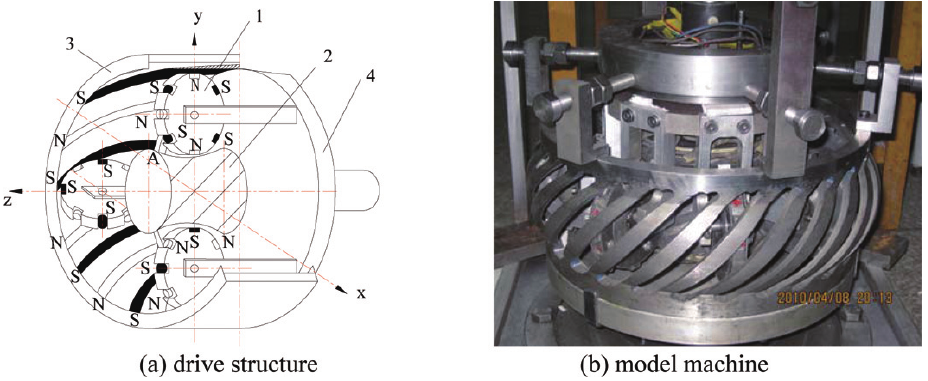
Fig. 1. Electromechanical integrated toroidal drive. 1. planet; 2. worm; 3. stator; 4.